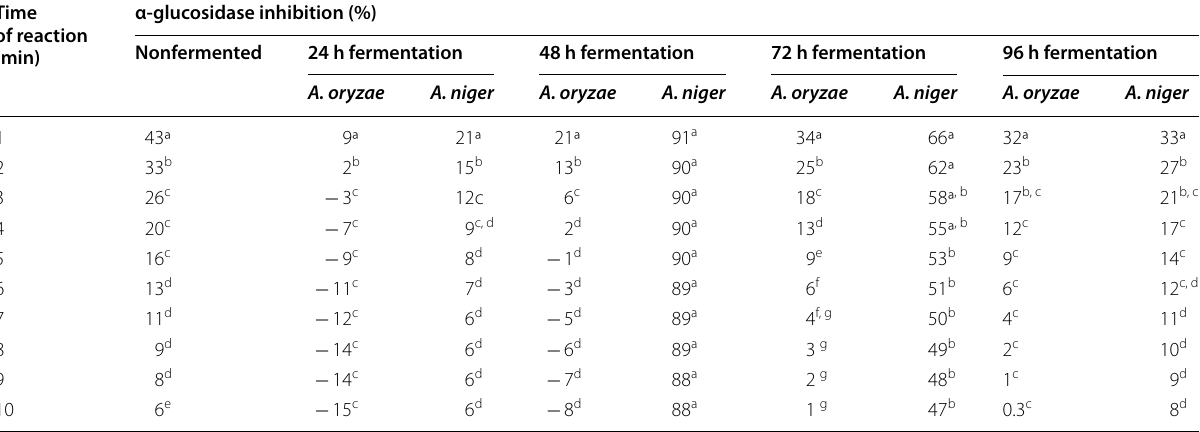
Results are presented as the mean ( n